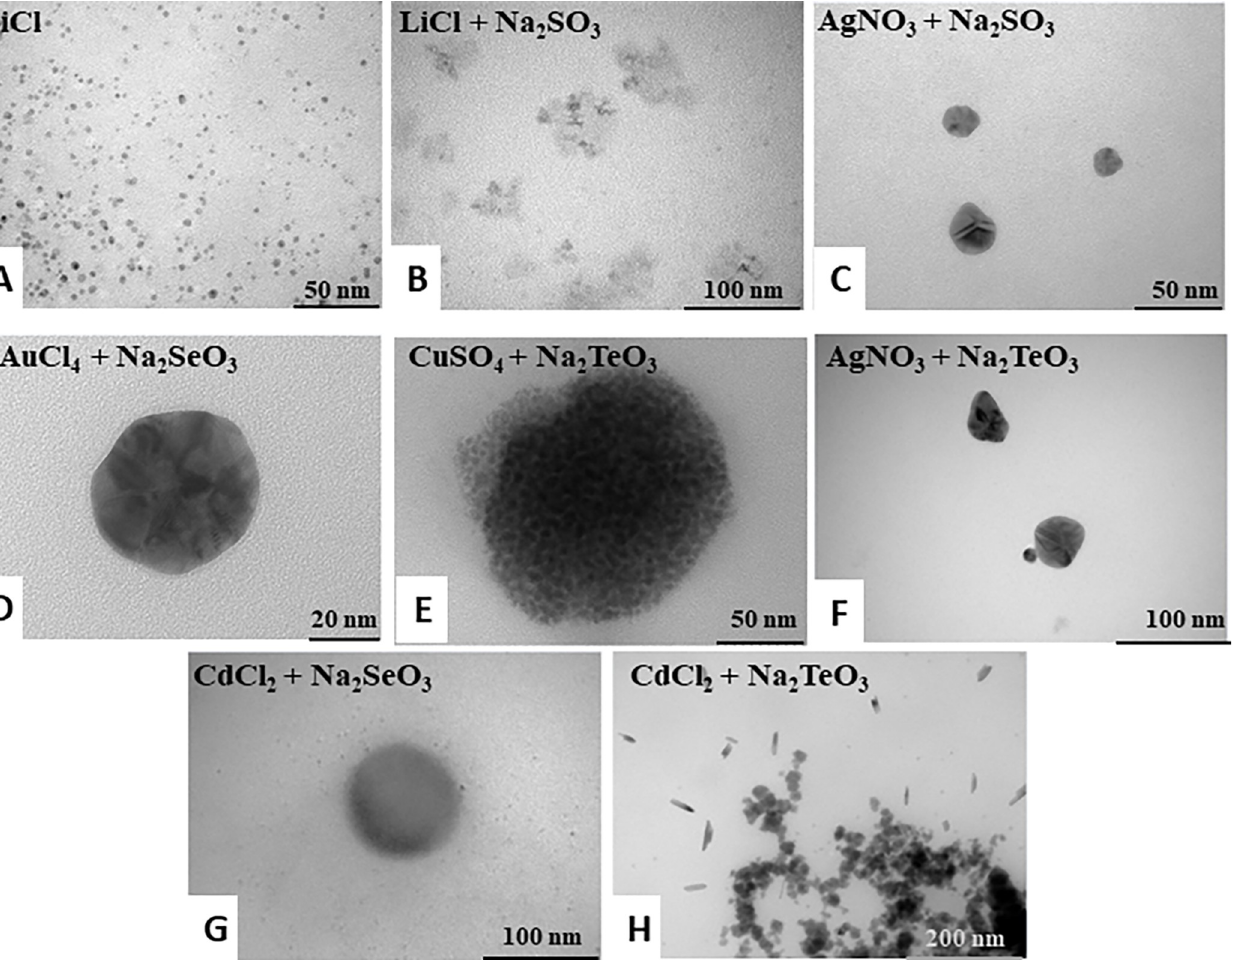
Fig 7. TEM of NS from in vitro synthesis by crude extracts of MF05. NS obtained after treatment with (A) LiCl; (B) LiCl + Na 2 SO 3 ; (C) AgNO 3 + Na 2 SO 3 ; (D) HAuCl 4 + Na 2 SeO 3 ; (E) CdCl 2 + Na 2 SeO 3 ; (F) CdCl 2 + Na 2 TeO 3 ; (G) CuSO 4 + Na 2 TeO 3 ; (H) AgNO 3 + Na 2 TeO 3 .